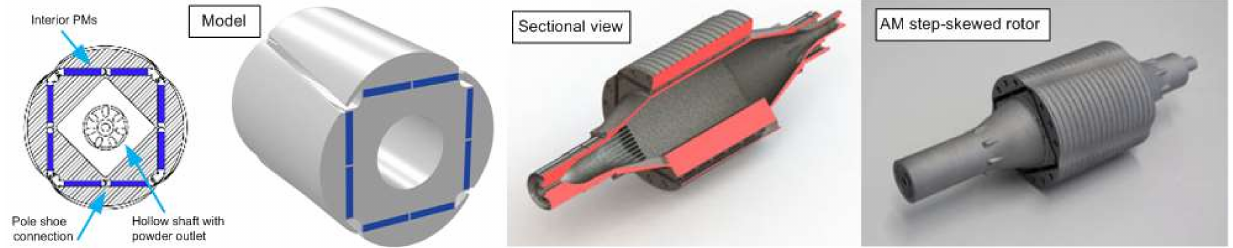
Figure 9. AM interior magnet-skewed rotor for PM synchronous machine with hollow shaft and lightweight construction [30].